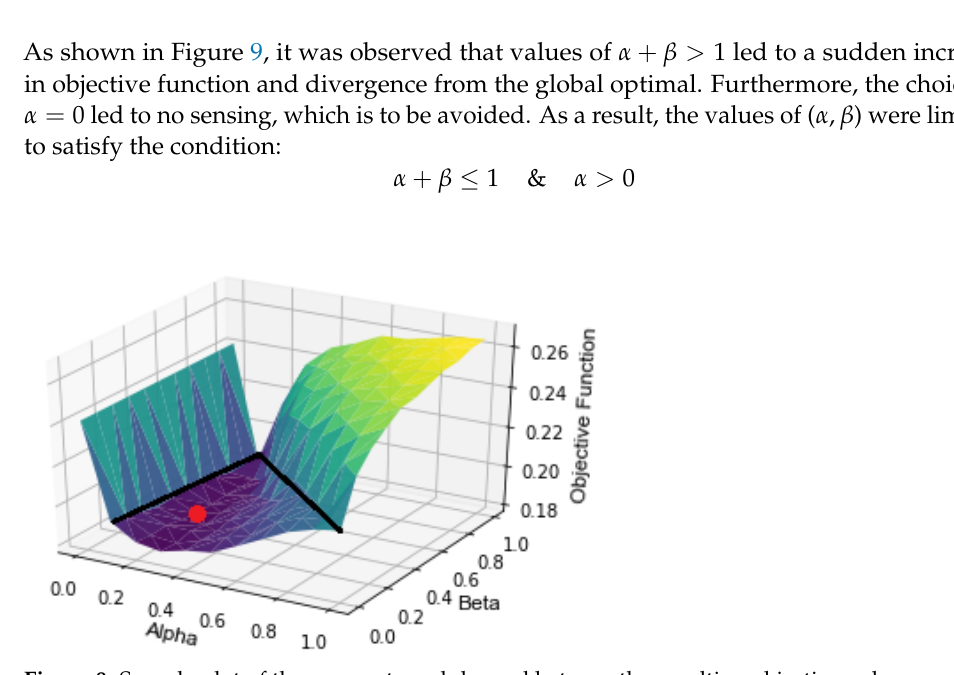
Figure 9. Sample plot of the parameters alpha and beta vs. the resulting objective value, resulting from the sensing schedules for different combinations of ( α , β ).